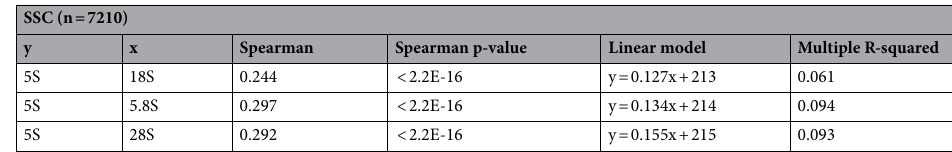
Table 1. Correlations between 45S and 5S rDNA copy numbers in the Simons simplex collection. The Spearman correlation coefficient and linear models that describe the relationships between the 45S and 5S rDNA copy numbers are